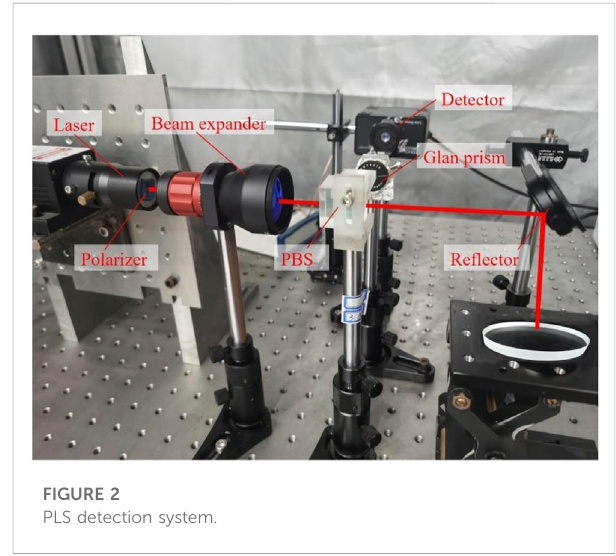
FIGURE 2 PLS detection system.